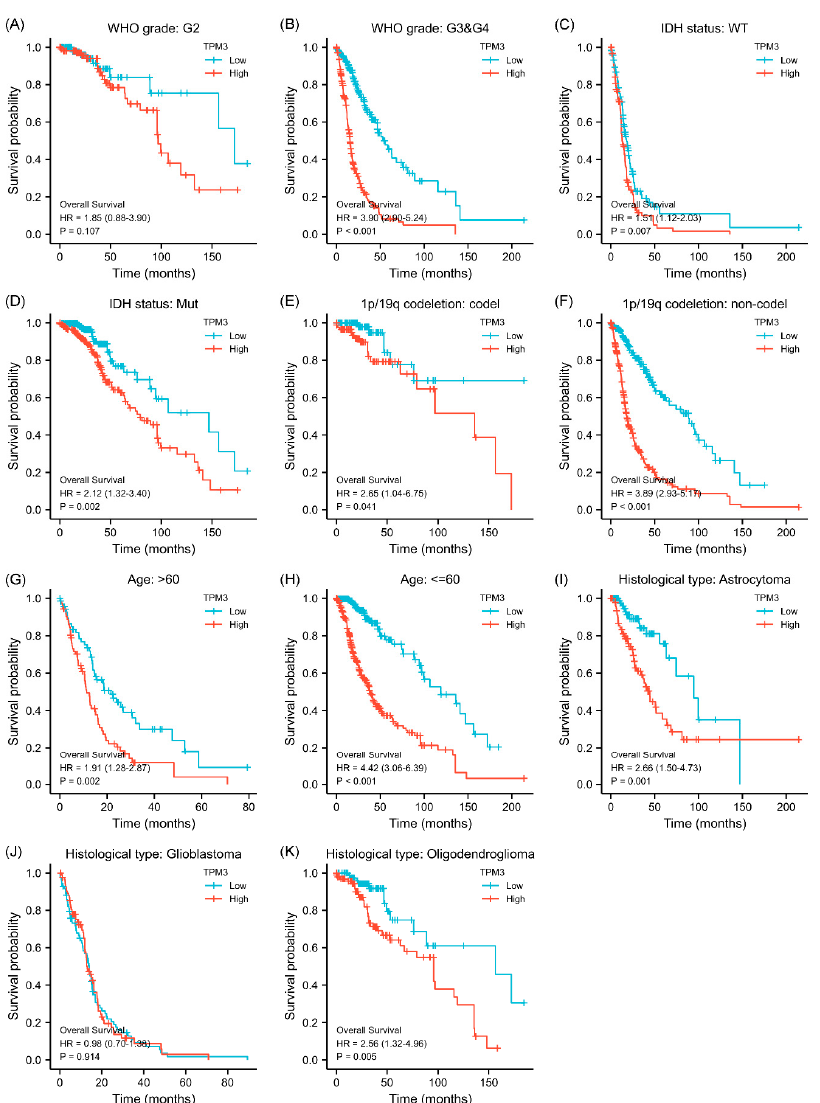
Figure 3. Subgroup survival analyses for the association between TPM3 expression and clinical characteristics. ( A , B ) Correlations between TPM3 expression and WHO grade. ( C , D ) Correlations between TPM3 expressions and IDH status. ( E , F ) Correlations between TPM3 expression and 1p/19q status. ( G , H ) Correlations between TPM3 expression and age. ( I – K ) Correlations between TPM3 expression and histological type.